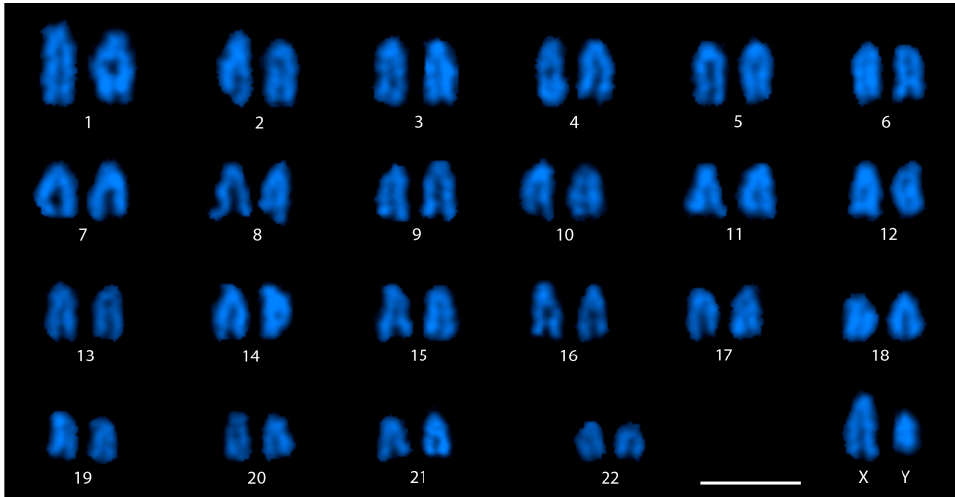
Figure 1. DAPI stained karyotype of male M. picta . Note the size difference between the X and Y. The chromosomes are arranged roughly based on their length. Bar: 3 µm.